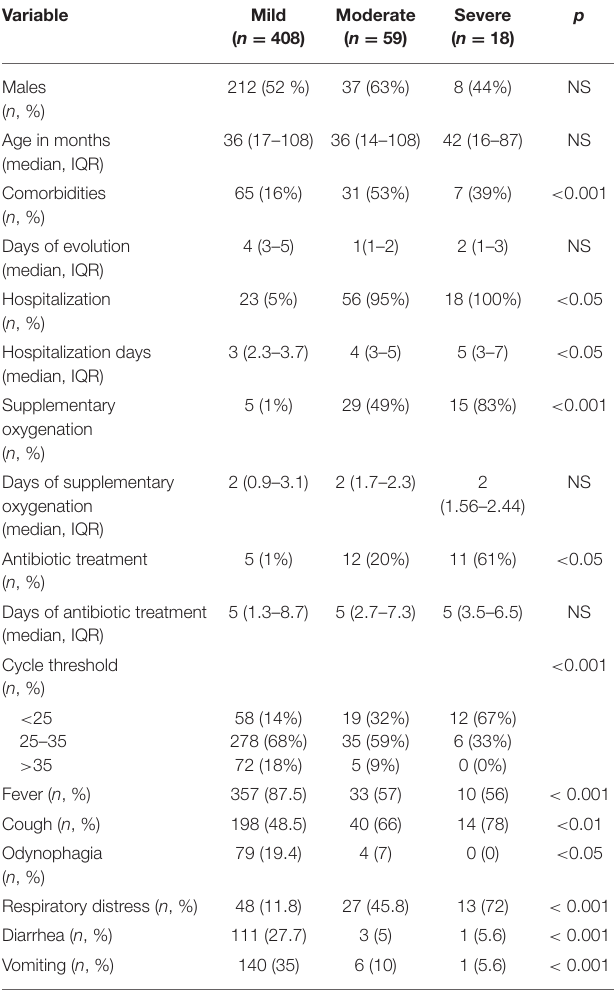
TABLE 1 | Presenting characteristics of the analyzed